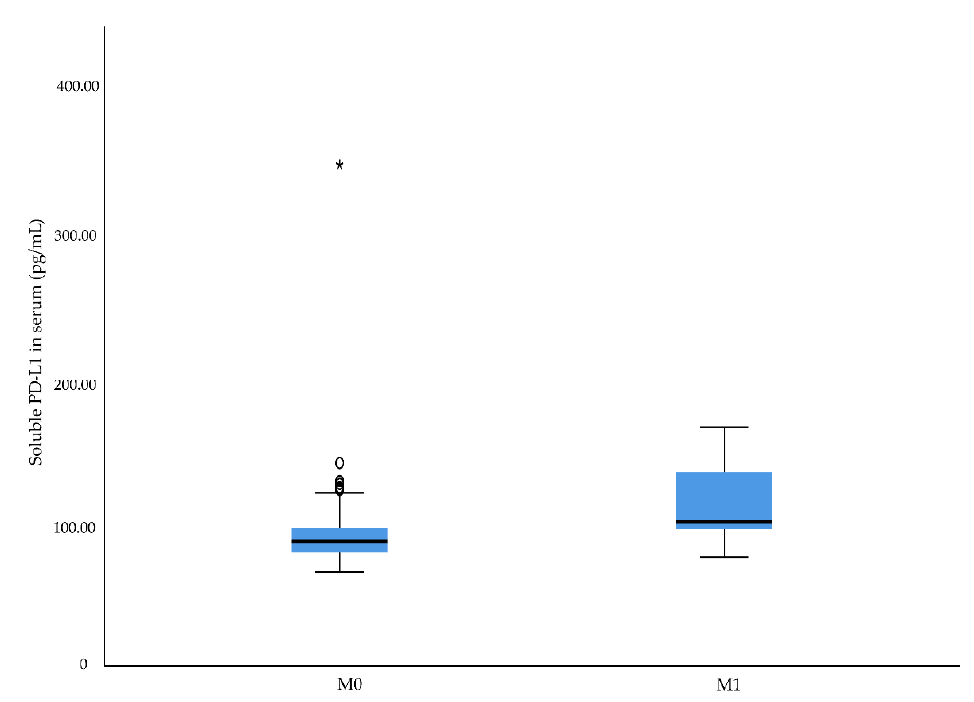
Figure 4. Soluble programmed death ligand 1 (sPD-L1) serum median levels in renal cell carcinoma patients with or without metastatic disease at time of diagnosis, p = 0.011. Outliers in the data are represented by a circle ( ◦ ), and extreme outliers are represented by an asterisk